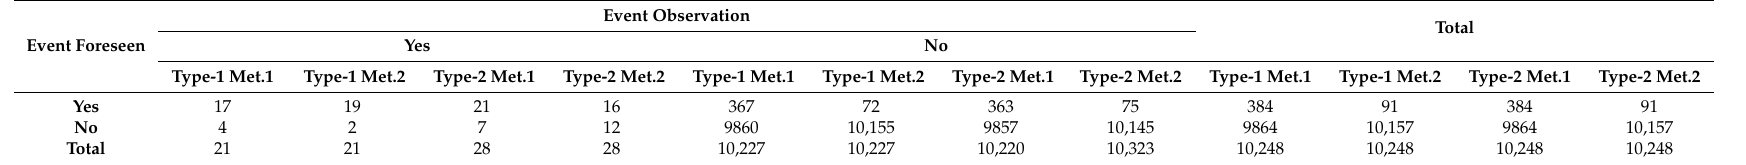
Table 7. Contingency table for downward ramps detected with Methodologies 1 and 2 for